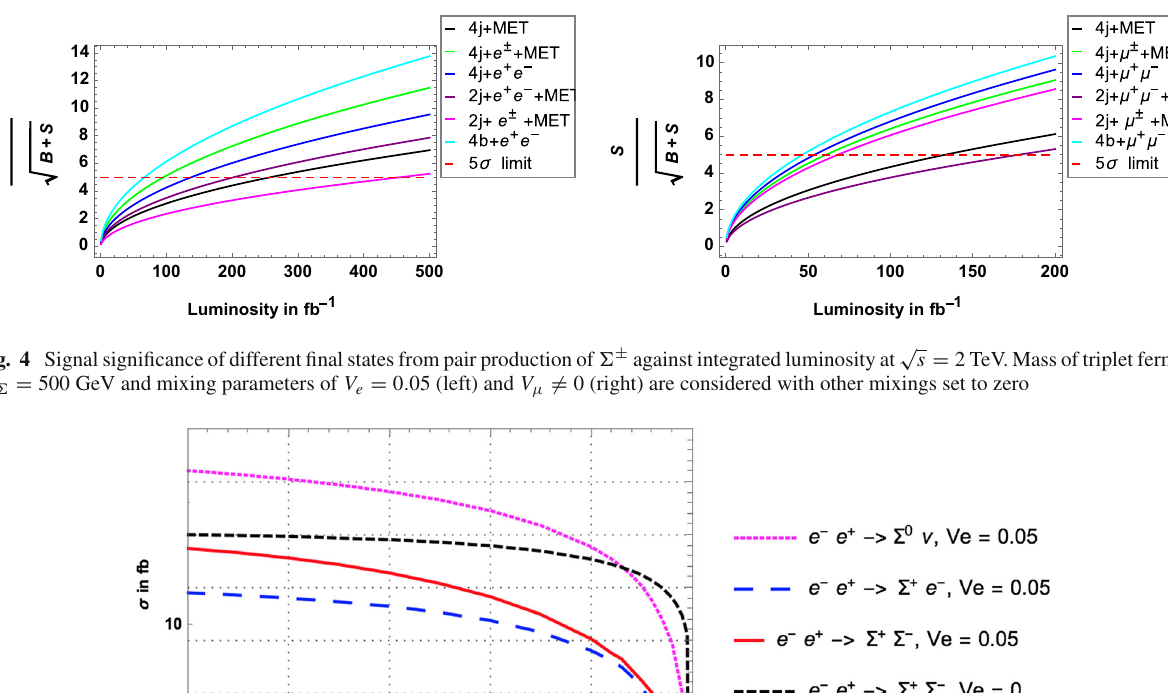
Fig. 5 Dependence of the cross section on the mass of fermions for pair and single production. Single production is considered at √ s = 2 TeV is considered for a pair production process. Mixing is considered as indicated, with V μ = V τ = 0 in all whereas